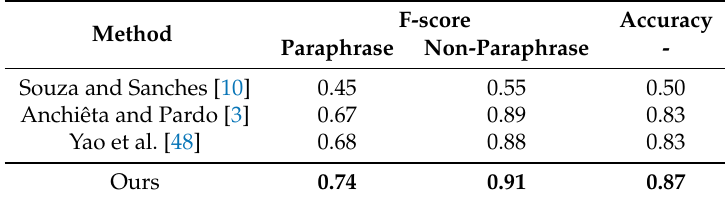
Table 8. Comparison among approaches on the balanced ASSIN